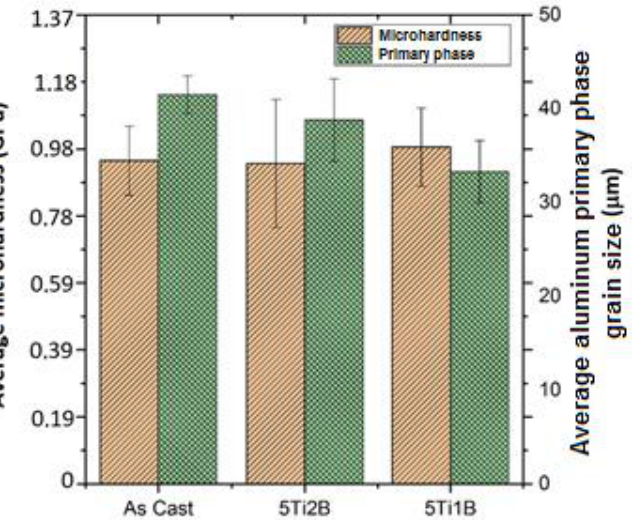
Figure 7. Variation of the primary phase grain size ( µ m) and microhardness (GPa) in the A332 alloy with different grain refiners.